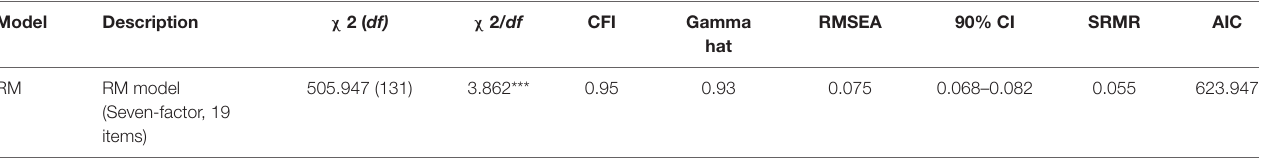
TABLE 9 | Model fit indices of research motivation model.